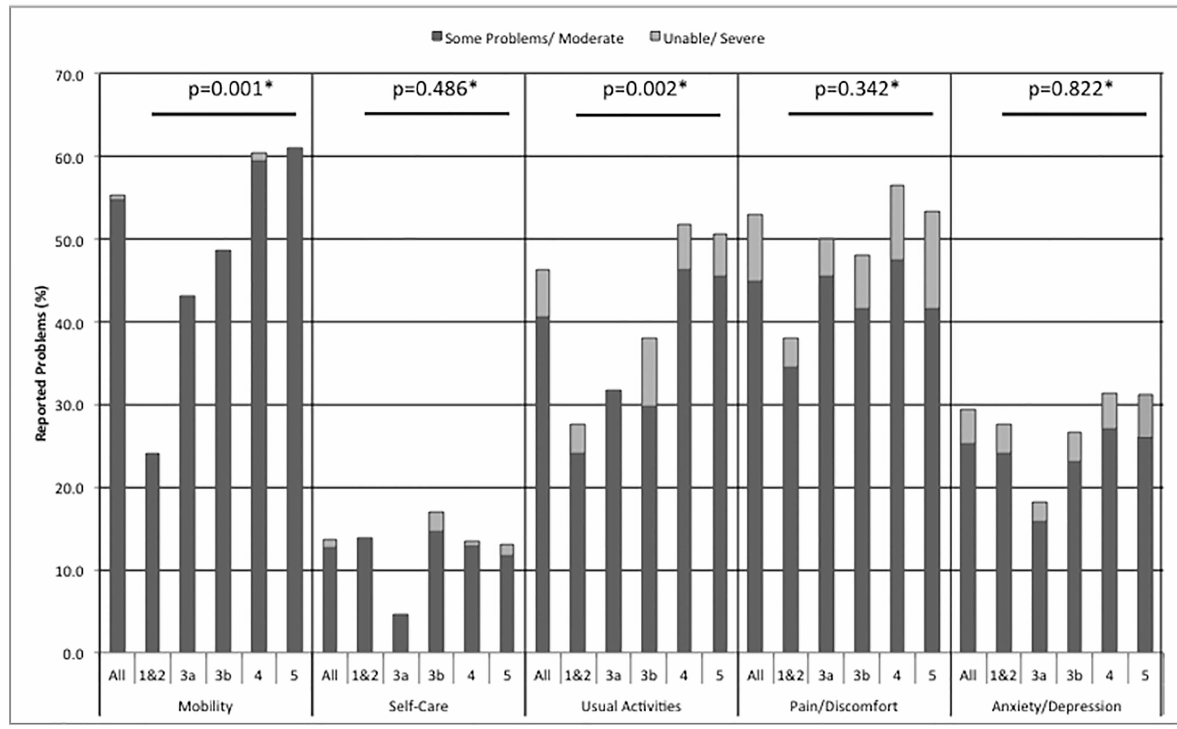
Fig 2. Reported HRQL Problems by EQ-5D domain. Data presented as wholecohort (All) and catagorised by CKD stage (determined by MDRD eGFR). * p-value for chi-squared test comparing CKD stage to reportedproblemsfor each EQ-5D-3L domain.